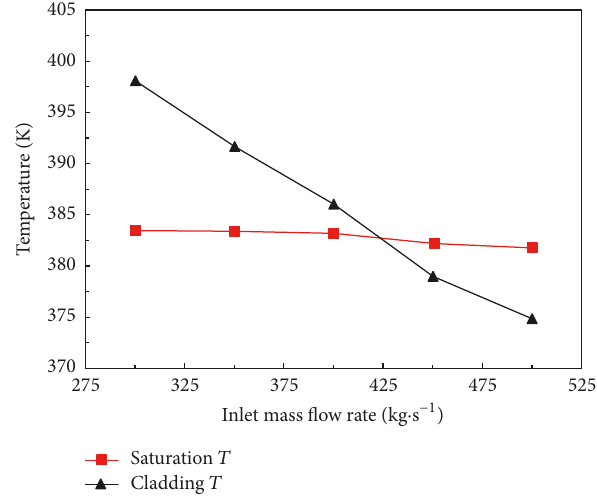
Figure 14: Calculated temperatures in the number 12 standard fuel assembly.